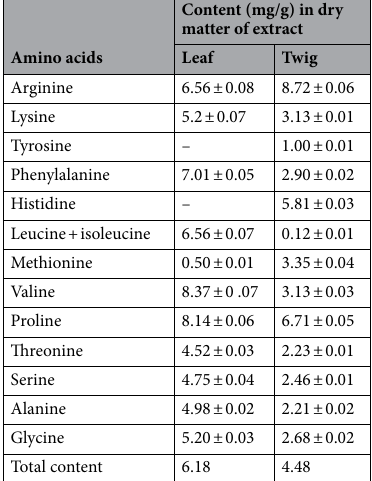
Content (mg/g) in dry matter of